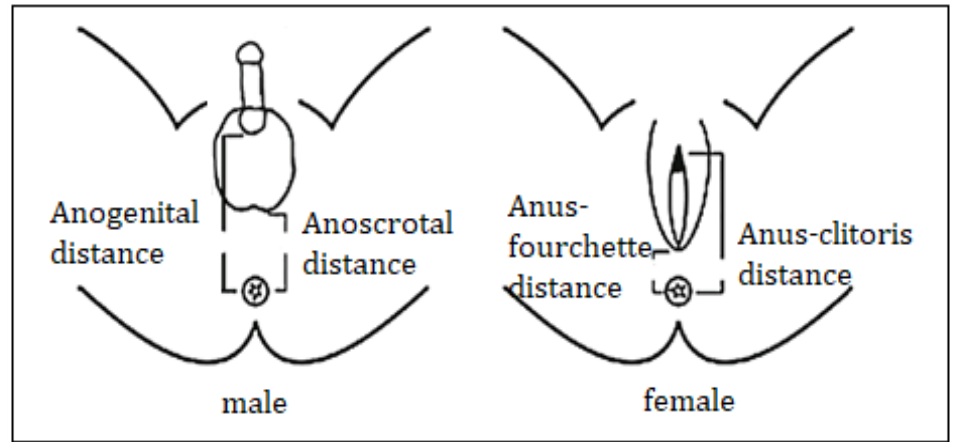
Figure 5. Measurement of different anogenital distances, markers of fetal androgens exposure [37].